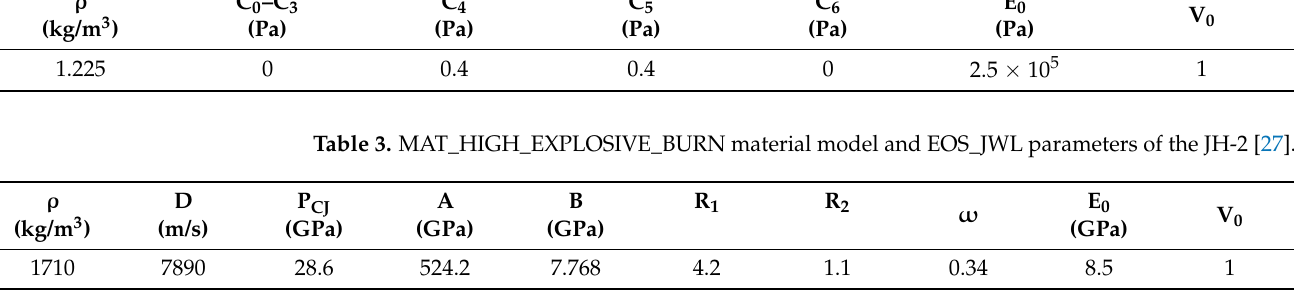
Table 2. MAT_NULL material model and EOS_LINEAR_POLYNOMIAL parameters of the air [26].